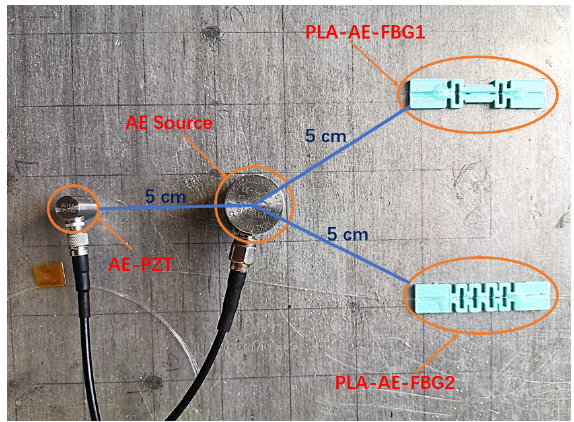
Figure 15. Experimental diagram of continuous AE signal detection.